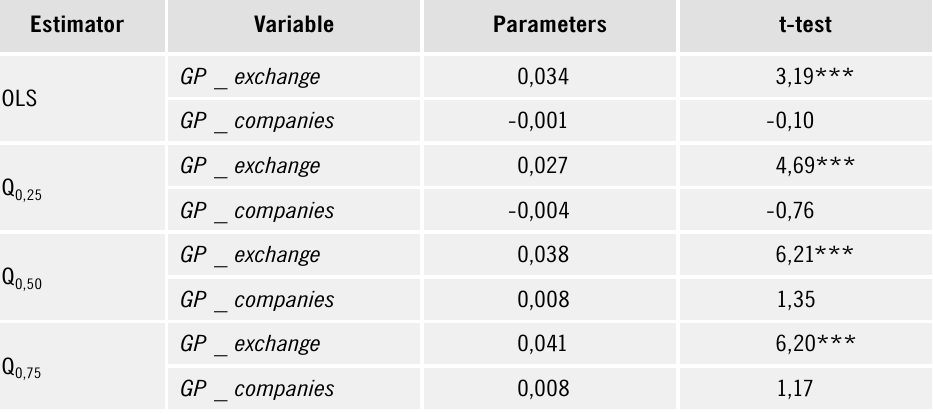
Table A4.2. OLS and quantile estimation of alternative SDI multiple